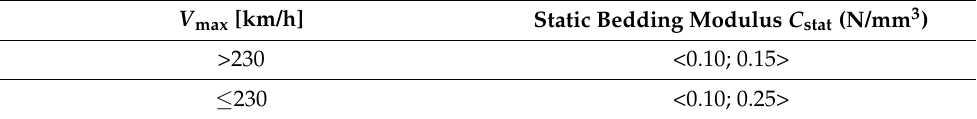
Table 1. Requirements for static bedding moduli of under ballast mats (UBM) used as protection of the ballast layer, according to DB regulations [25,26]. V max [km/h] >230